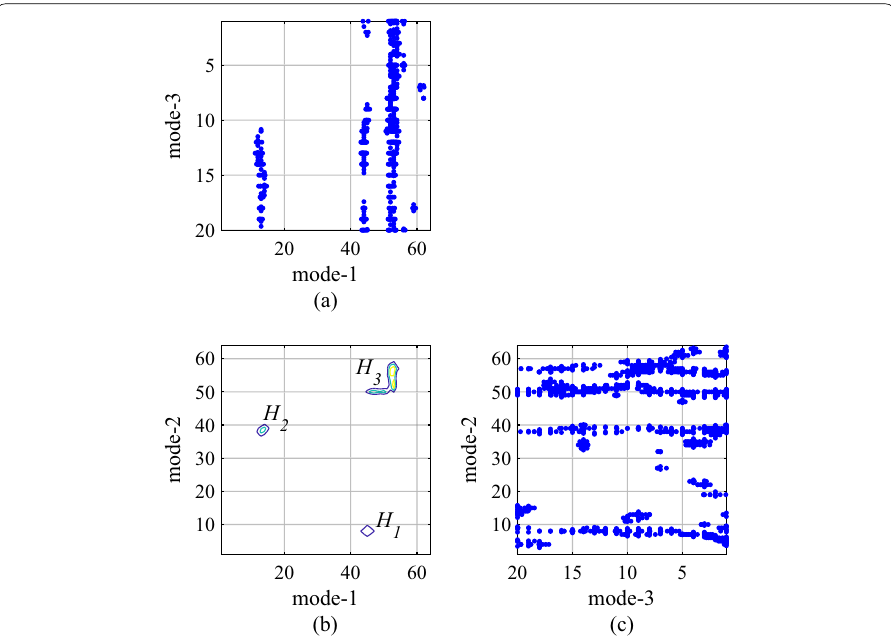
Fig. 5 Phase congruency in data tensor D in Fig. 2. a , c Scatter plots along mode-3. b 3-level contour